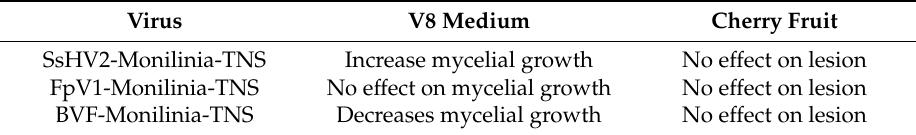
Table 4. Possible effects on mycelial growth by each